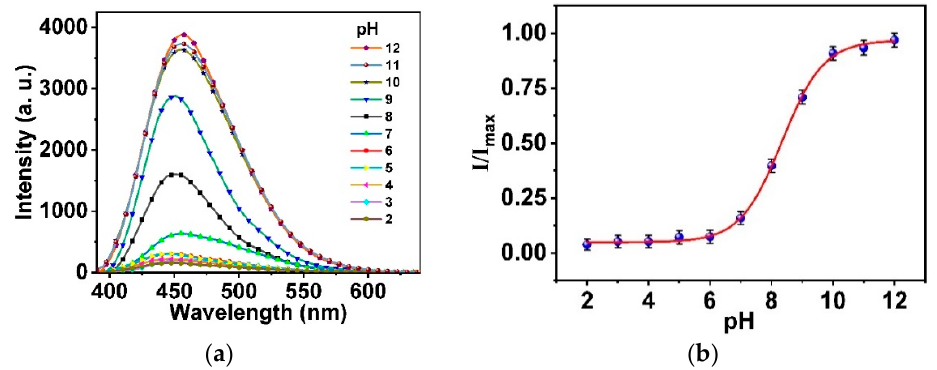
Figure 7. ( a ) Emission spectra of salicylamide in aqueous solution at different pH ranging (2–12) upon excitation with 350 nm; ( b ) calibration curve of I/I max (452 nm) at different pH.